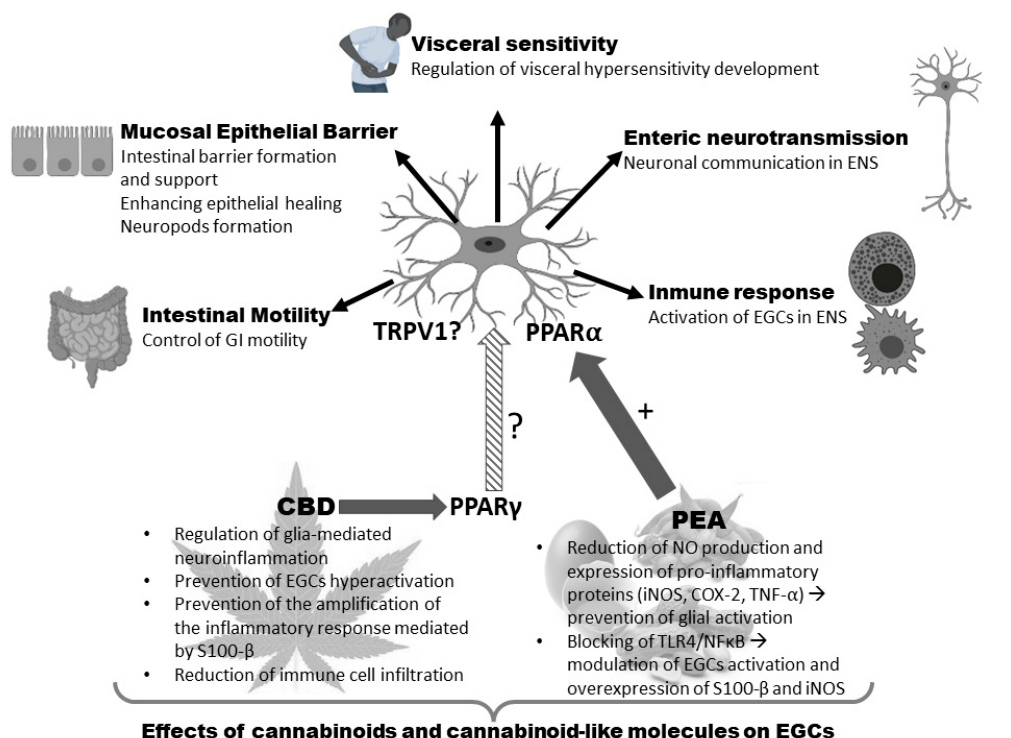
Figure 4. Effects of cannabinoids and cannabinoid-like molecules on enteric glial cells. +: activation;